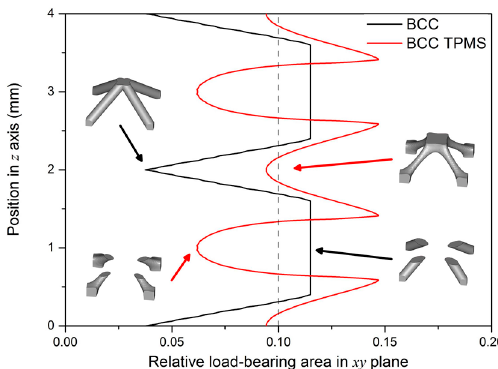
Figure 4. Relative load-bearing area of CAD-based and TPMS-based BCC unit cell along the load direction.